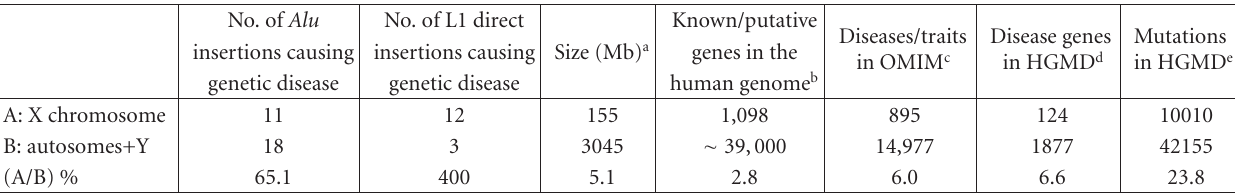
Table 2: X-chromosome/autosome comparison with respect to gene number, disease genes, known mutations, and retrotranspositional insertion